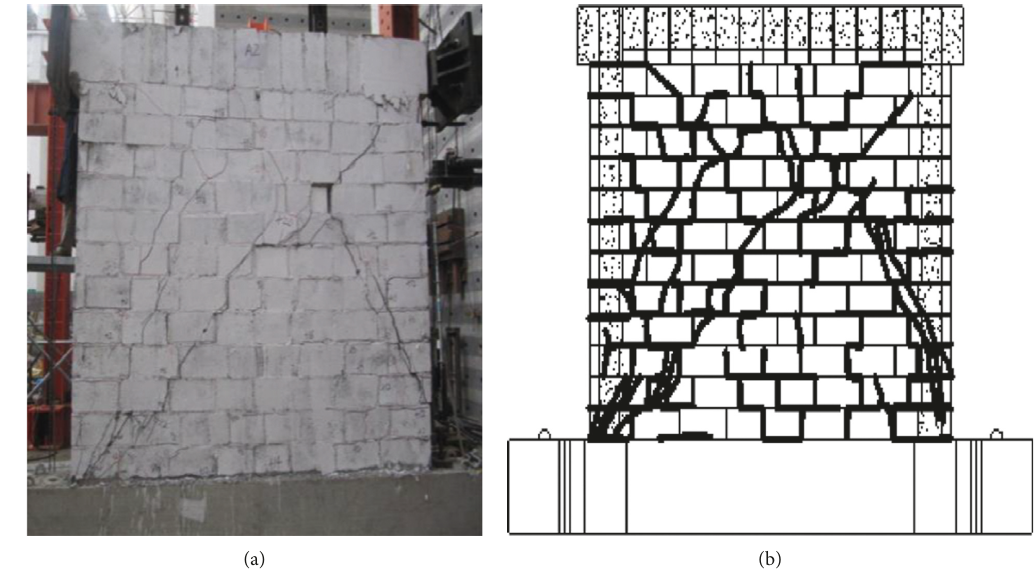
Figure 9: (a) Failure mode and (b) crack distribution of wall